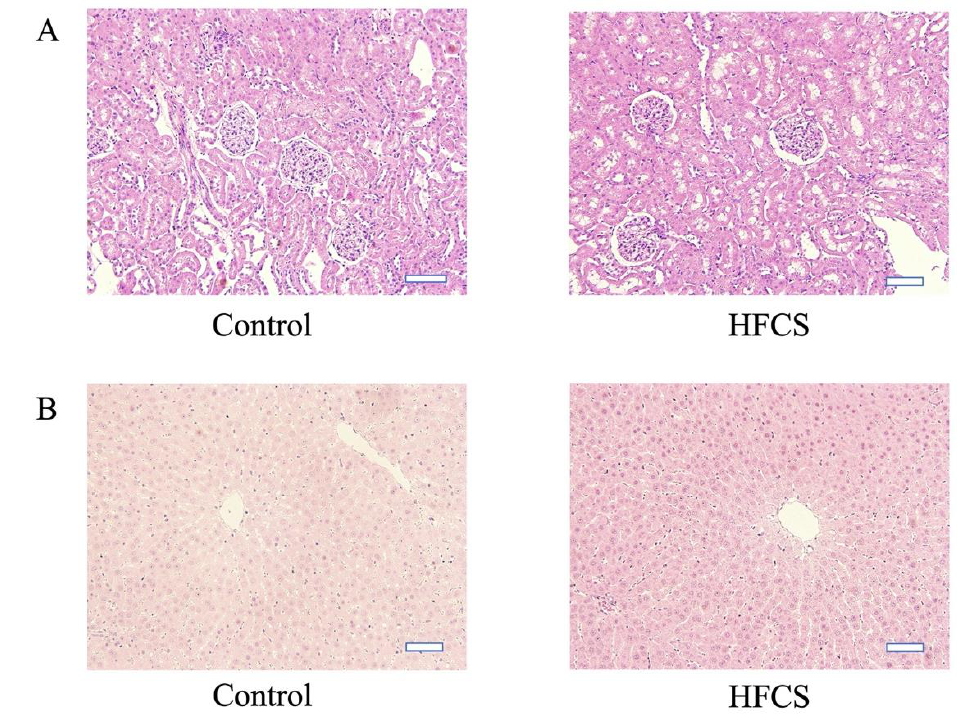
Figure 1. Representative images of hematoxylin and eosin-stained Wistar rat kidney ( A ) and liver ( B ) tissues from the high-fructose corn syrup (HFCS) and control groups. The scale bar represents 50 µm.